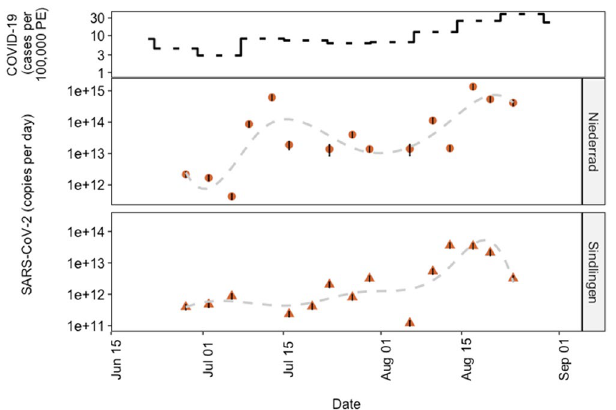
Figure 3. SARS-CoV-2 RNA loads analyzed with RT-qPCR in the influent of the two WWTP, i.e. Niederrad and Sindlingen, and the count of registered COVID-19 cases in the city of Frankfurt (top).